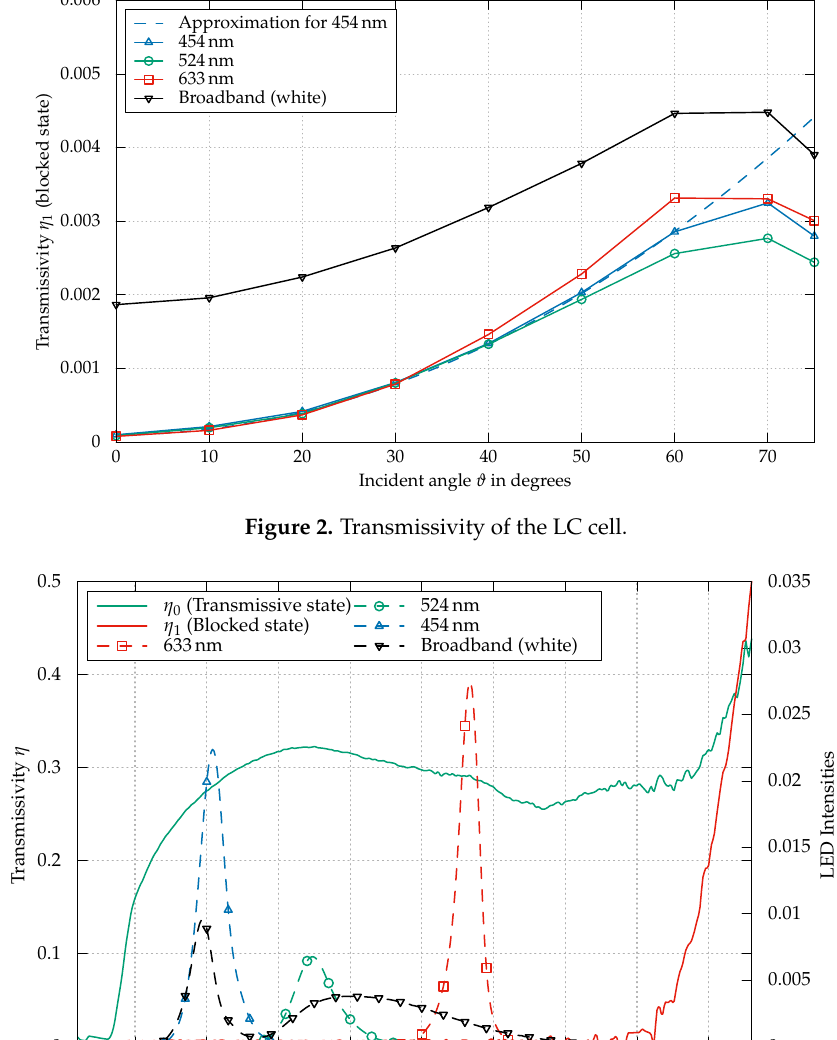
Figure 3. Spectral measurement results for the LC cell and the four different